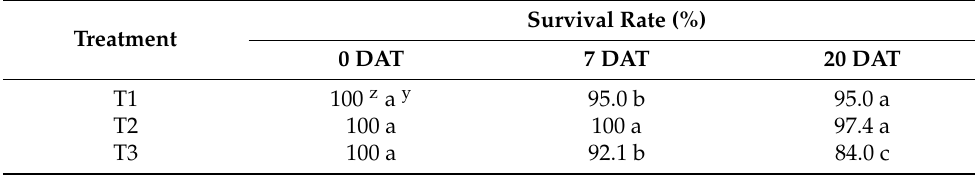
Table 1. Effect of temperature on the survival rate of apple seedlings at 20 days after treatment in a growth chamber. T1, T2 and T3 indicate day/night temperature 18/18 ◦ C, 23/18 ◦ C and 30/18 ◦ C,